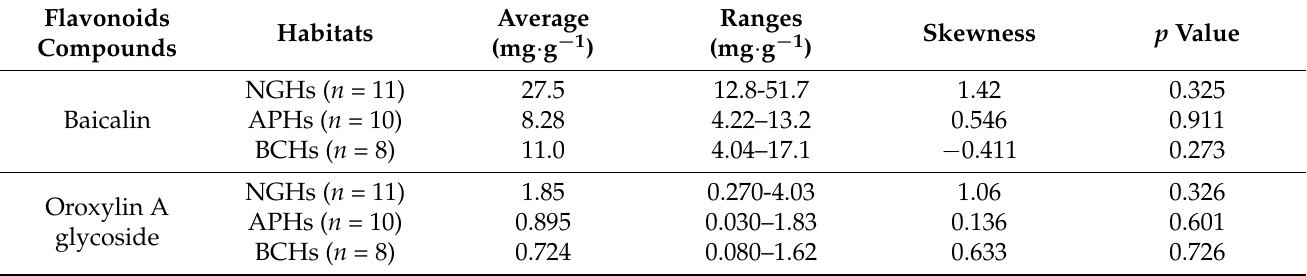
Table 4. Statistical characteristics of flavonoid compound contents in the roots of Scutellaria baicalensis